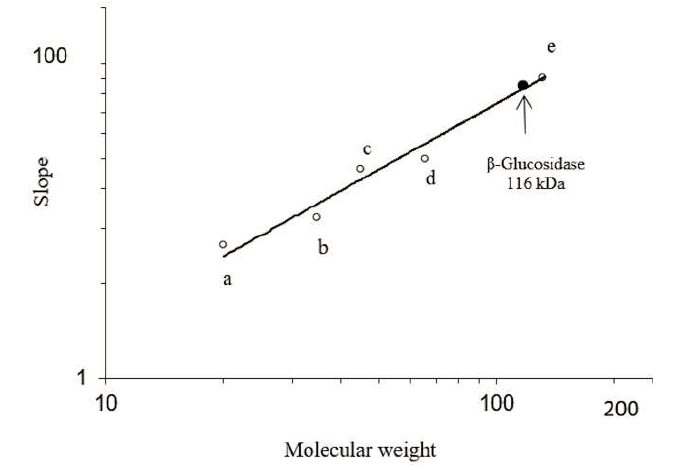
Figure 4. Determination of molecular weight of β -glucosidase in Sechium edule from non-denaturing conditions. Electrophoresis on gels at 5%, 7.5%, 10% and 12.5% polyacrylamide concentrations, at pH 8.3 were performed, and the relative R f of the proteins in each gel, relative to the tracking dye (bromophehenol blue), was plotted. Molecular weight standards were: (a) α -lactalbumin (14,200); (b) carbonic anhydrase (29,000); (c) ovalbumin (45,000); (d and e) bovine serum albumin (monomer, 66,000; and dimer